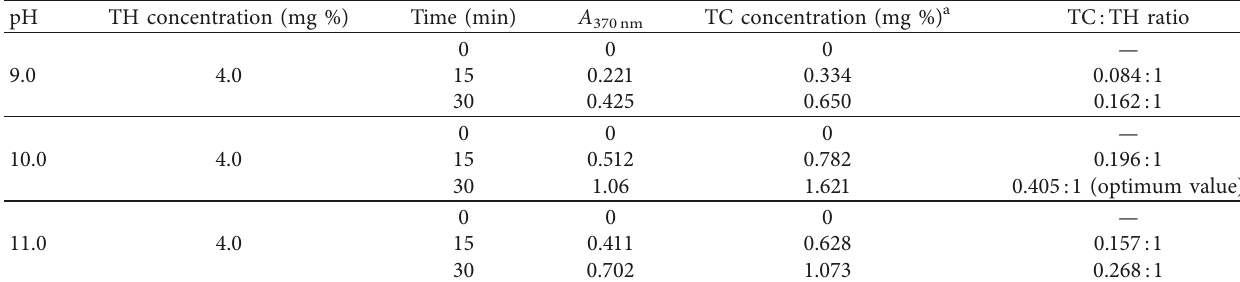
Table 3: TC: TH ratios for UV irradiated TH solutions (4mg %) at pH 9.0–11.0.